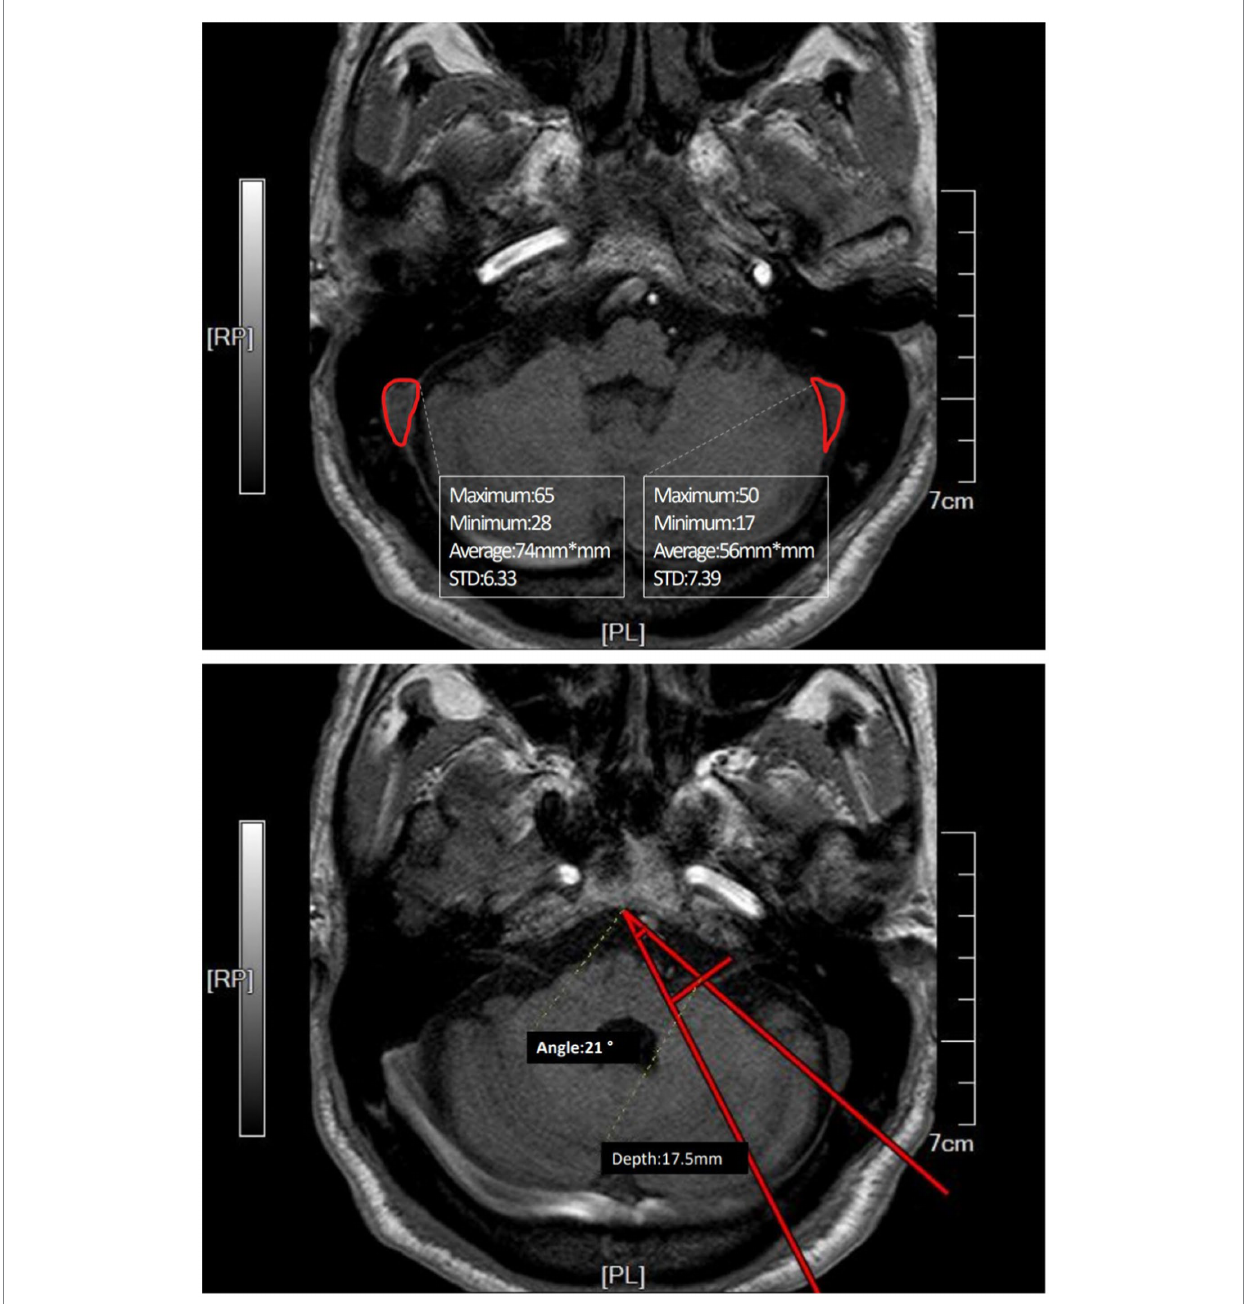
FIGURE 2 Preoperative MRI image of a case where the affected side and the dominant side are ipsilateral (right side). The area of the sinus was measured in the plane of REZ (root entry zone) where the root of the facial nerve is located. The angle was measured by connecting the midpoint of the REZ plane slope and the sinus border to the responsible blood vessel at its deepest point. The distance from the responsible blood vessel’s deepest point to the perpendicular line from the deepest point of the angle to the petrous bone wall was the depth of the responsible blood